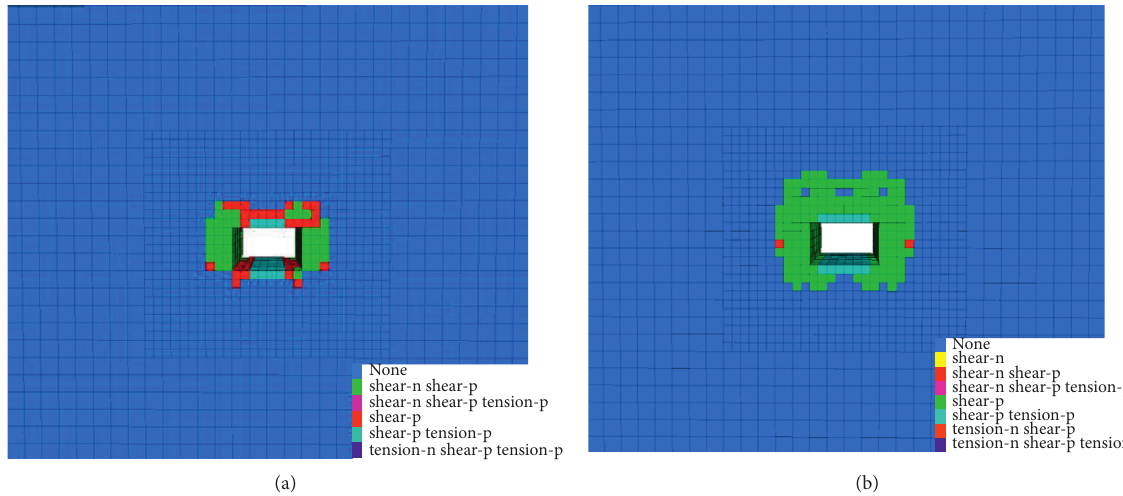
Figure 8: Distribution of the plastic zone of the surrounding rock (a) before applying disturbance load and (b) after applying disturbance load.